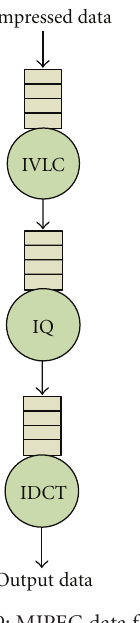
Figure 19: MJPEG data flow.